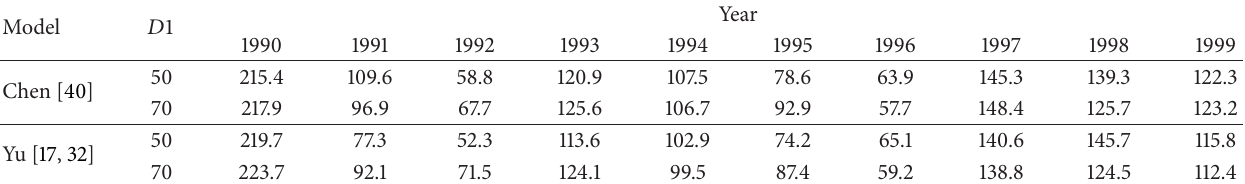
Table 1: Forecasting performance for TAIEX with length =